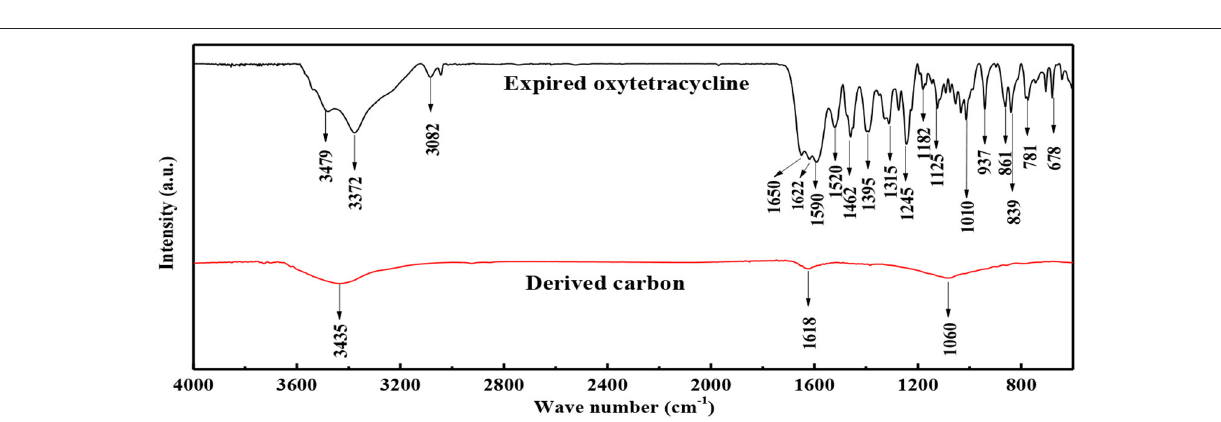
FIGURE 3 | FTIR spectra of expired oxytetracycline and expired-oxytetracycline-derived carbon